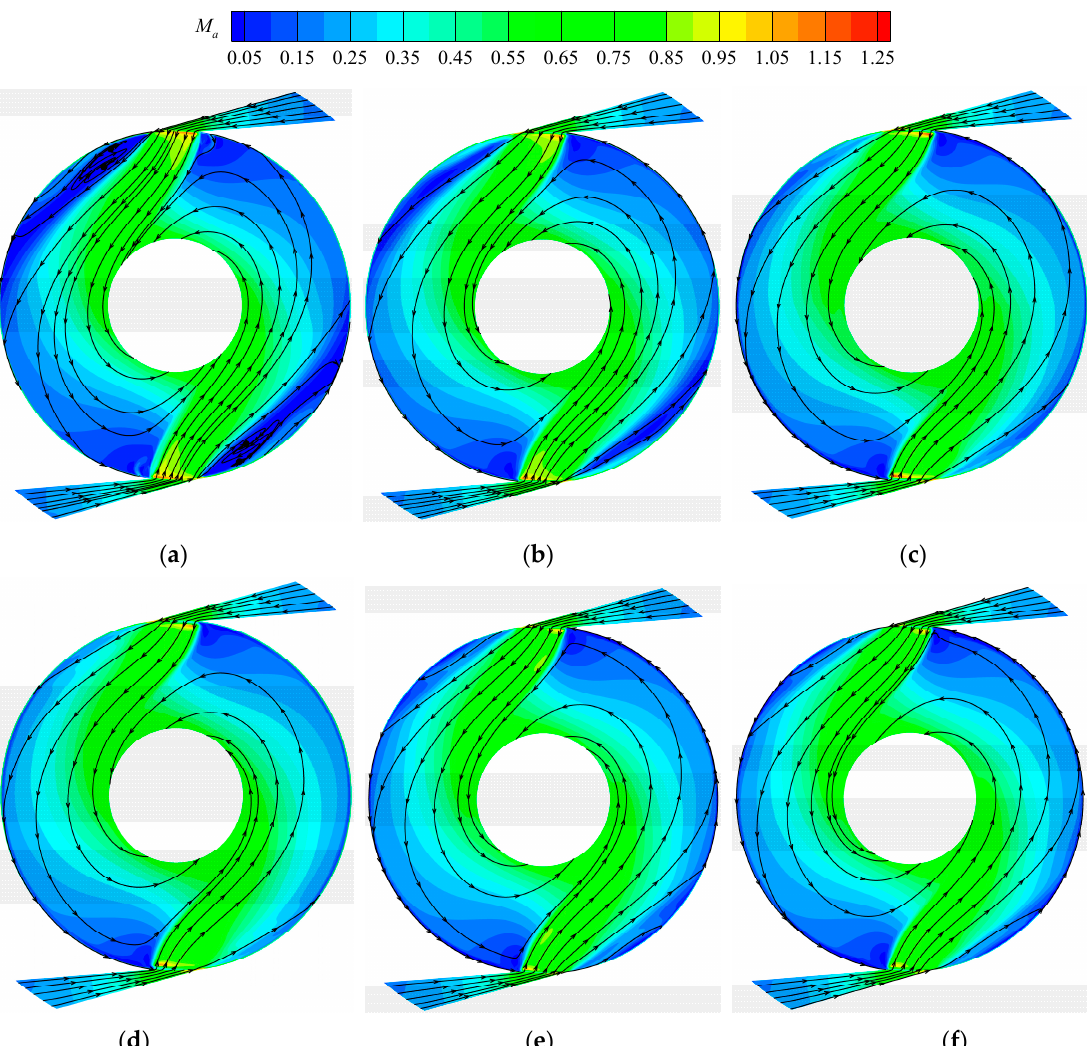
Figure 17. Streamlines and Mach number distributions on the middle of DC1 for different turbine models. ( a ) OTM-B; ( b ) OTM-T-1; ( c ) OTM-T-2; ( d ) OTM-T-3; ( e ) OTM-C-2; ( f ) OTM-E-3.